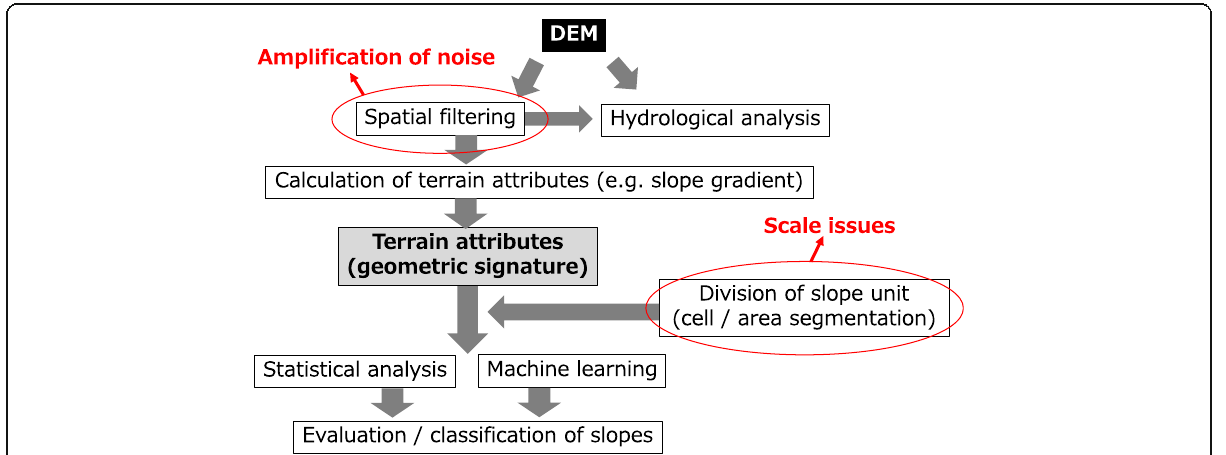
Fig. 4 Flowchart of terrain classification using DEM with noise and scale problems (red notes). This flowchart assumes the process of Iwahashi et al. (2018a)